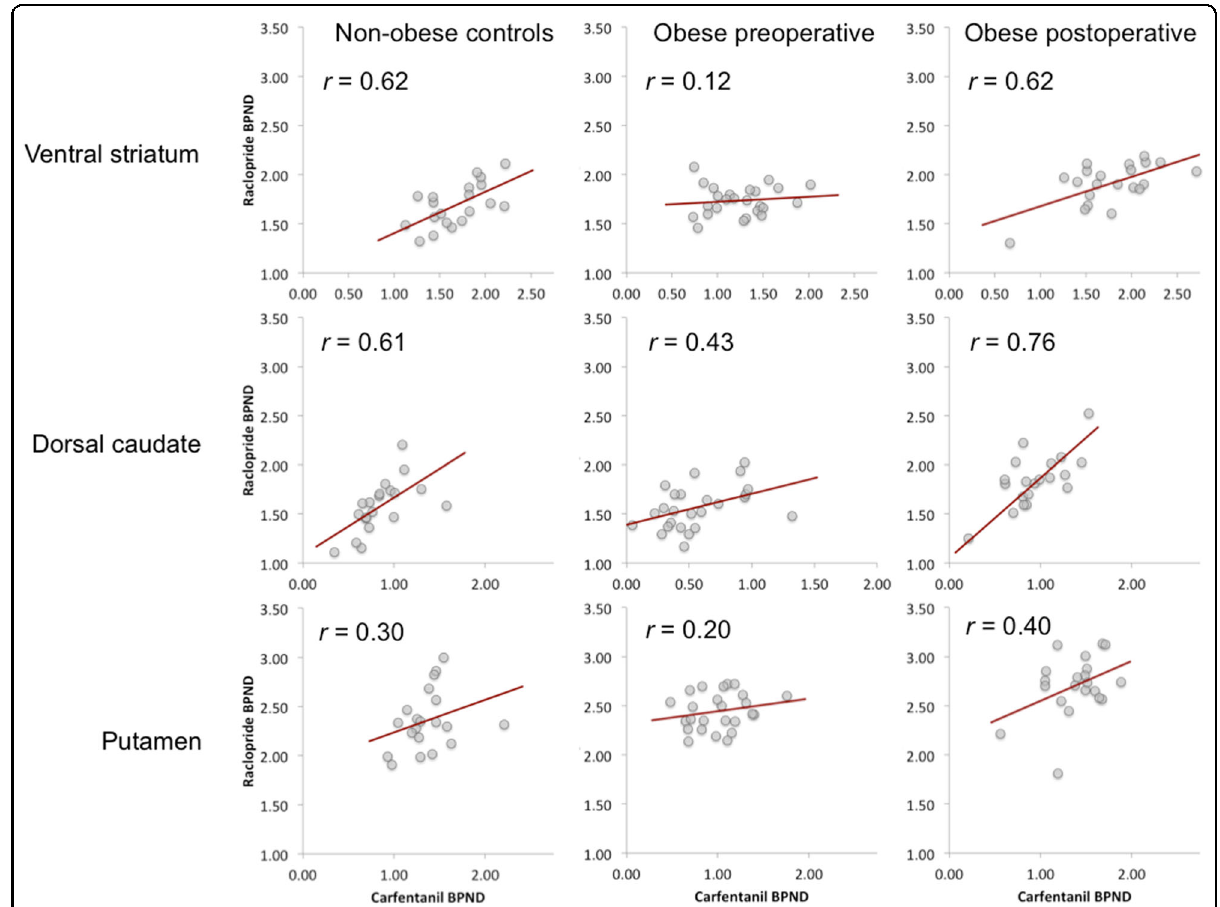
Fig. 1 Correlations between [ 11 C]raclopride BP ND and [ 11 C]carfentanil BP ND in the ventral striatum, dorsal caudate, and putamen. The association is recovered in the ventral striatum after surgery-induced weight loss. A signi fi cant association was found in dorsal caudate in all groups, whereas no association was found in the putamen in any group.